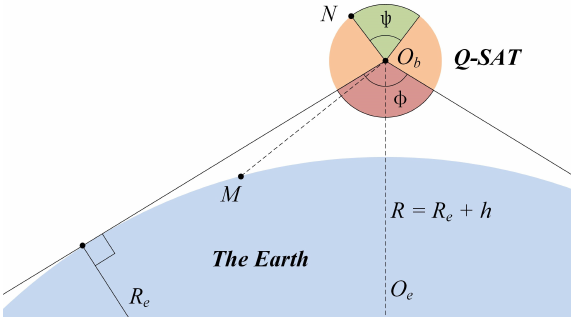
Figure 12. The impact of Earth albedo on different solar cells. O b M is the radius of the influence area of the albedo effect, and O b N is perpendicular to O b M . Solar cells in red are sheltered from the sunlight. Solar cells in green cannot be influenced by the albedo effect. Solar cells in the yellow region can be influenced by both the sunlight and the albedo